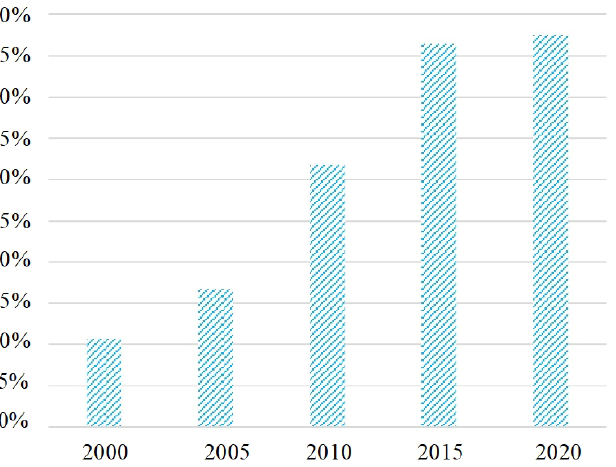
Figure 3. Reclamation rate of paddy land with 5-year interval from 2000 to 2020 in the study area.